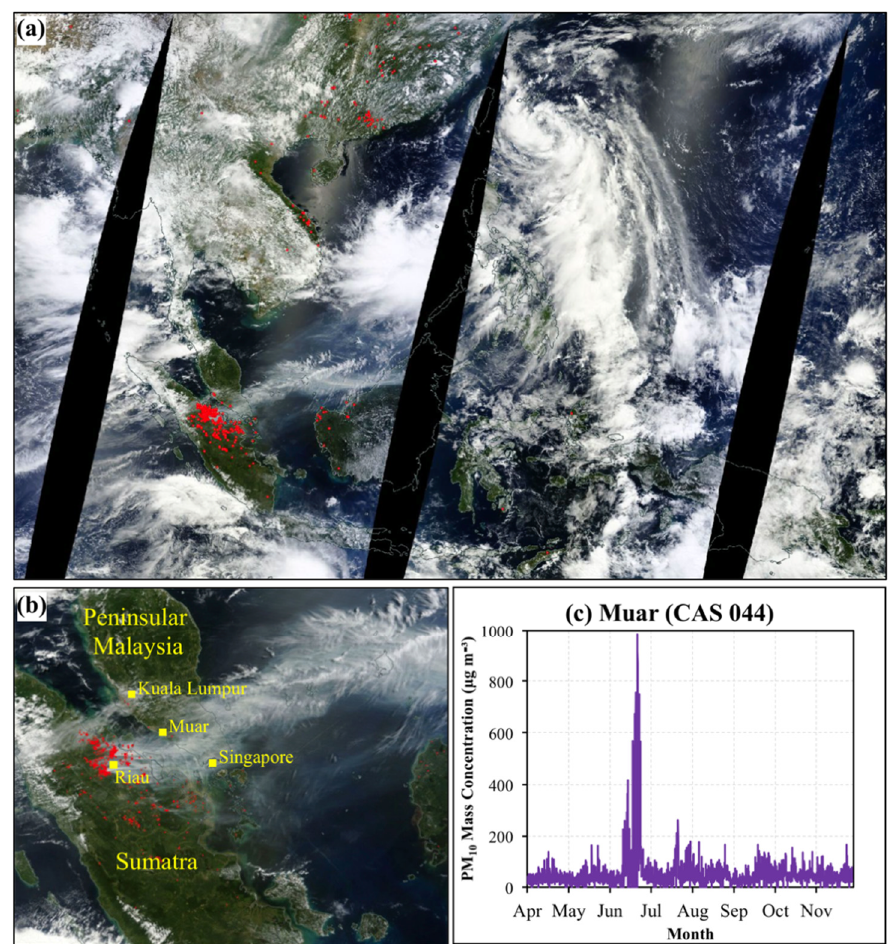
Figure 1. Haze over Sumatra and Peninsular Malaysia in June 2013. Satellite image from NASA’ s Moderate Resolution Imaging Spectroradiometer (MODIS) Terra satellite on 19 June 2013 over ( a ) Southeast Asia and ( b ) Sumatra and Peninsular Malaysia. The red dots correspond to the location of fire hotspots detected by MODIS. ( c ) Time series of observed PM 10 mass concentrations (provided by the Malaysia Department of Environment (DOE Malaysia)) over Muar in Malaysia from April to November 2013.